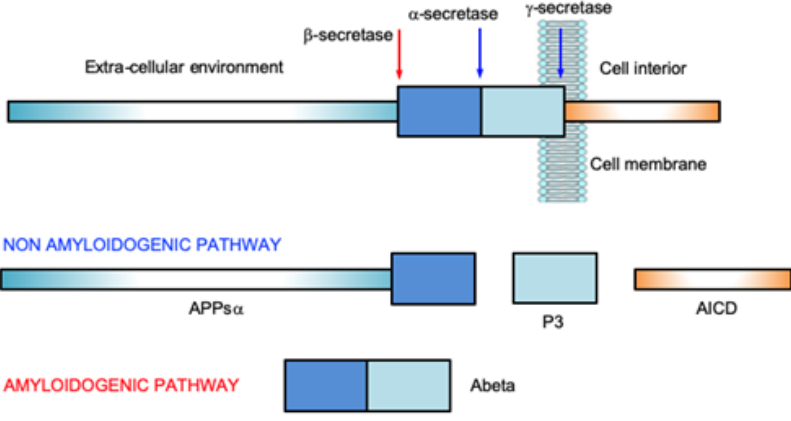
Figure 1. Results of the different cleavage sites of APP by the secretase enzymes. The non-amyloidogenic pathway is the consequence of the involvement of α - and γ -secretases, and it results in the formation of the APPs α , P3 and AICD (APP Intracellular Domain) fragments. While APPs α and P3 still have unknown functions, the latter moves to the nucleus and there regulates gene expressions and the apoptosis process [16]. In the amyloidogenic pathway, β - and γ -secretases operate the enzymatic cut, thus originating the Abeta fragments [17]. Recent evidence has suggested that Abeta42 can also be generated by the action of meprin β , a metalloprotease that acts at the same cleavage site of BACE1 [18]. α -Secretase activity is ascribed to the ADAM metalloproteases, among which it has been shown that ADAM 9, 10, 17 and 19 hold α -secretase action [19]. In particular, the over- expression of ADAM 10 in AD mouse reduced plaque formation and cognitive failure